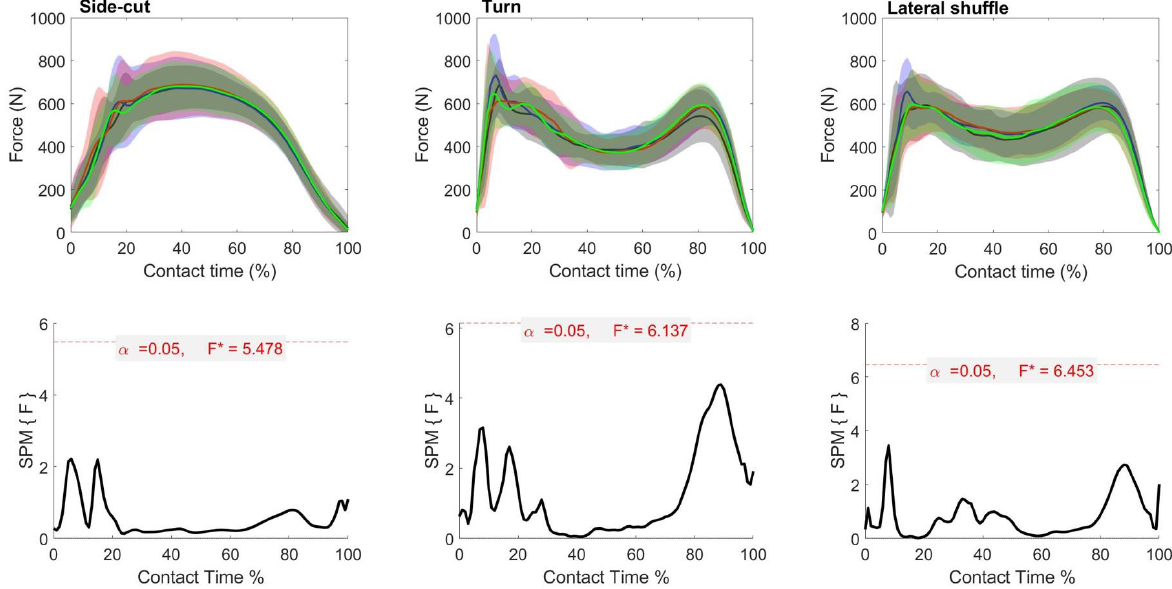
Figure 4. Mean (SD) resultant horizontal ground reaction force results across participants for each Scheme. F* = critical value.